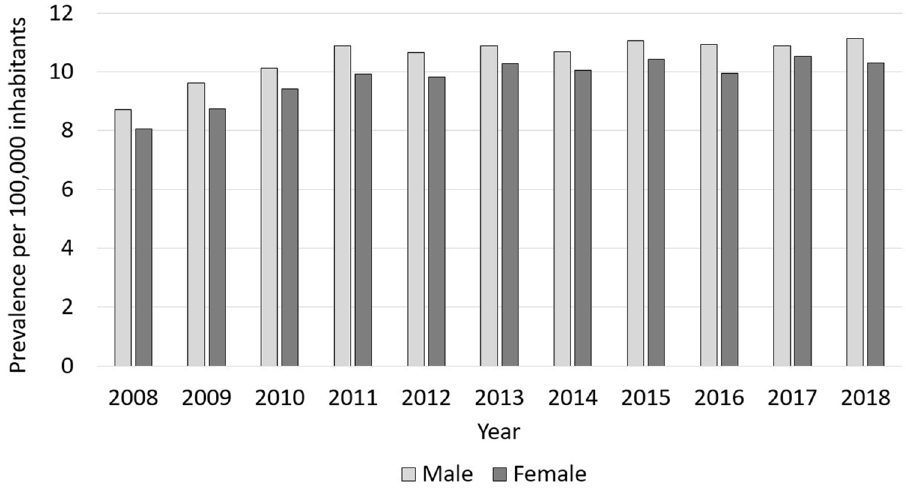
Figure 1. Development of FRI prevalence from 2008 to 2018. The prevalence of men diagnosed with FRI is shown in light grey, the prevalence of female cases is illustrated in dark grey.